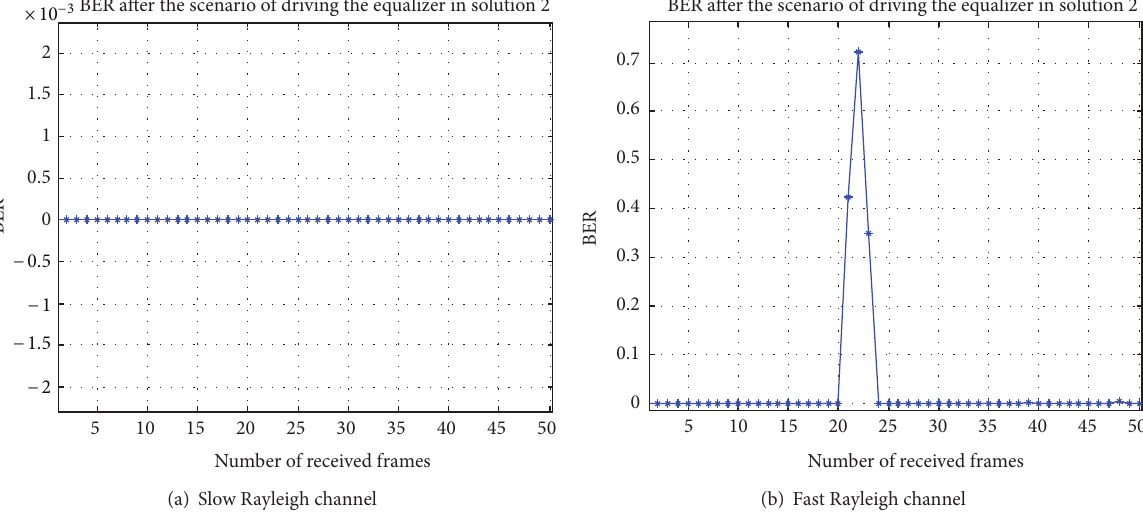
F 14: Performance of the system aer decision making for the rayleigh channel with solution